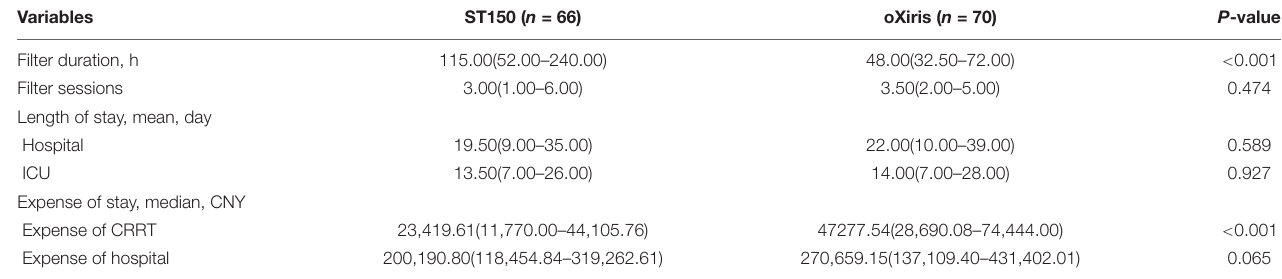
TABLE 4 | The secondary outcomes.